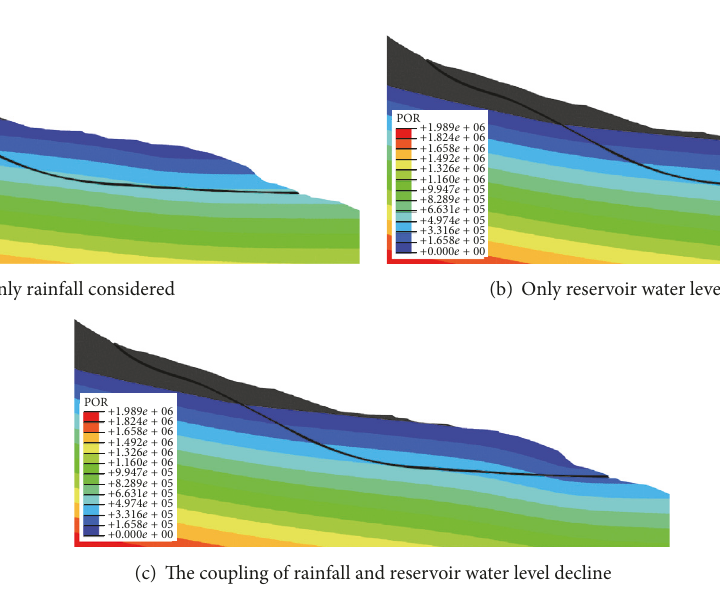
Figure 8: The distribution of pore water pressure under different boundary conditions (unit,